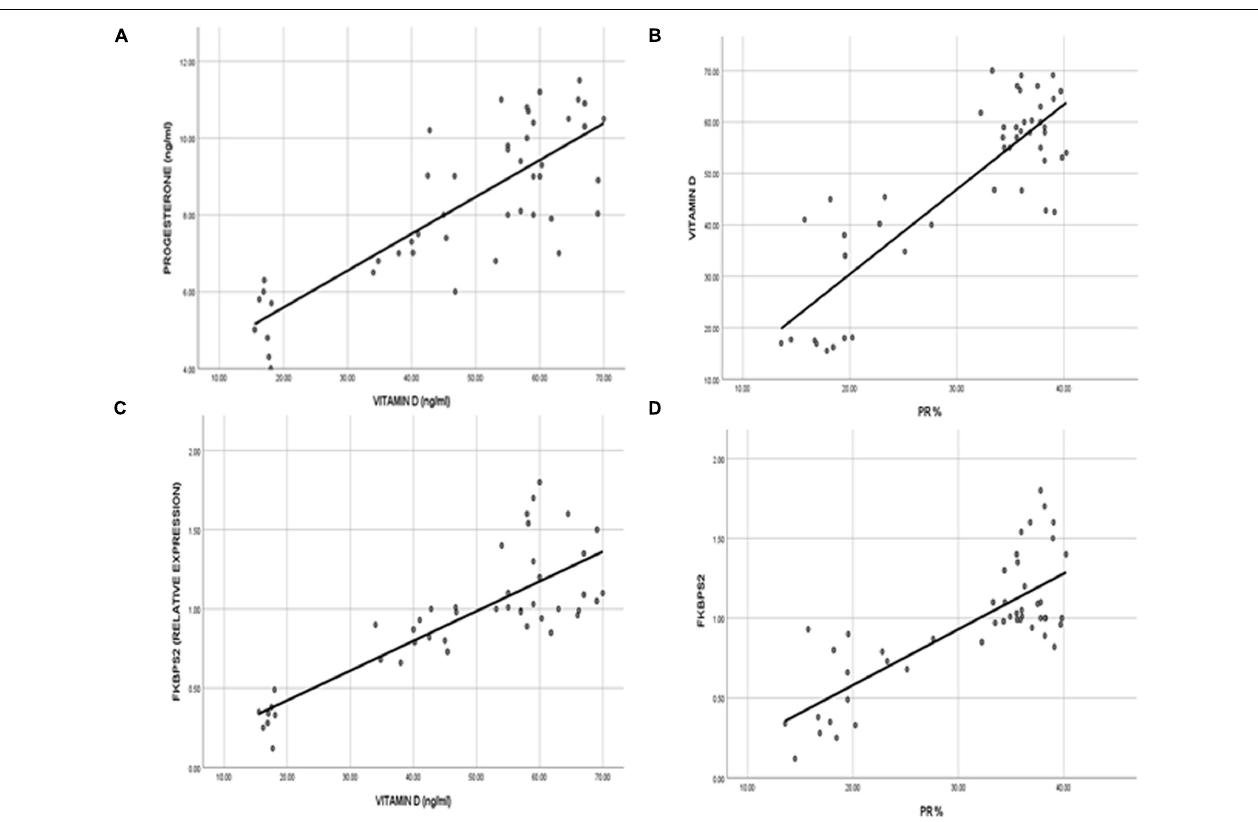
FIGURE 9 | The correlation represented the direct relationship between VD levels and (A) the serum progesterone level and (B) the uterine progesterone receptor expression. VD revealed a direct correlation to the (C) uterine immunophilin FK506-binding protein 52 (FKBP52), which was correlated significantly to (D) the progesterone receptor expression in the uterine